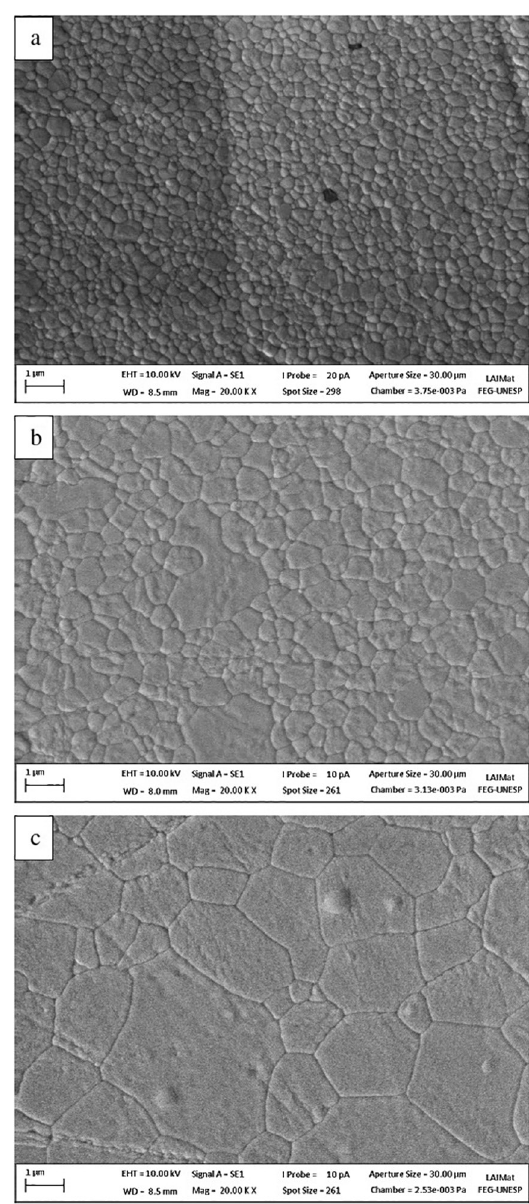
Figure 3: SEM micrographs showing different average grain size of samples sintered at: a)1450 °C, b)1530 °C - 2 h and c)1600 °C - 4